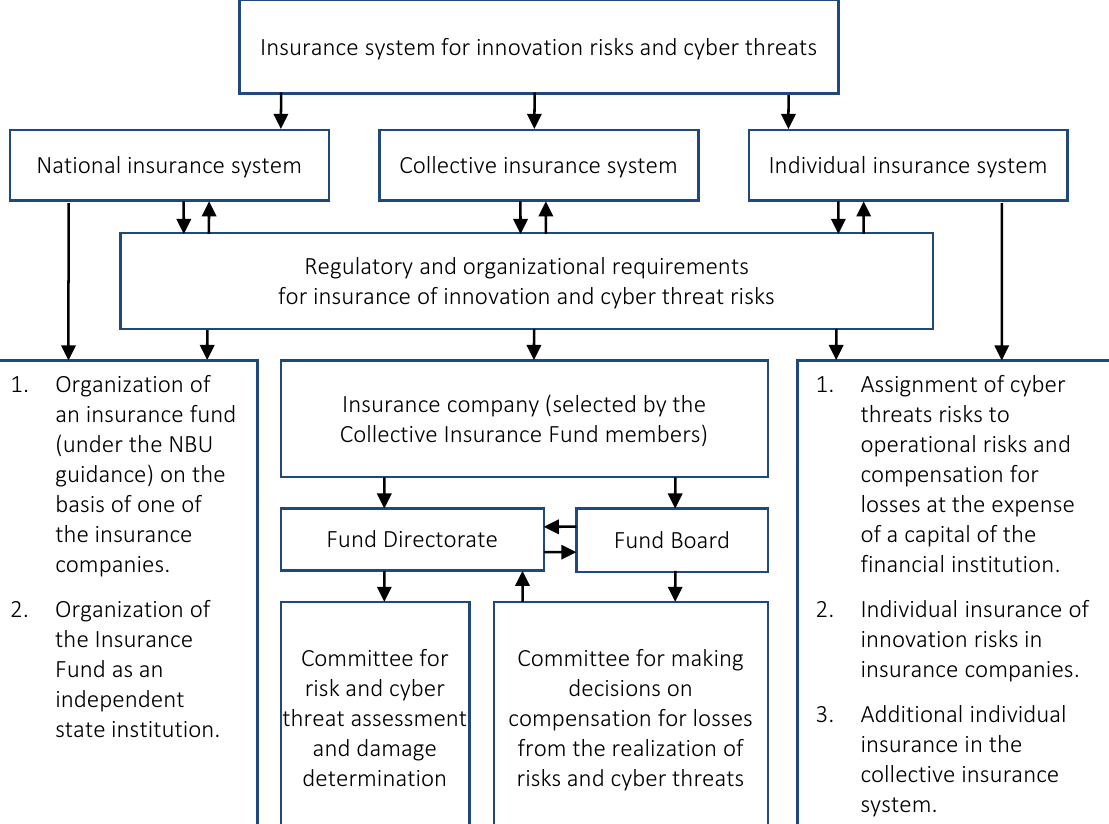
Figure 4. Options for organizing a Collective Insurance Fund for ICT and innovation-related